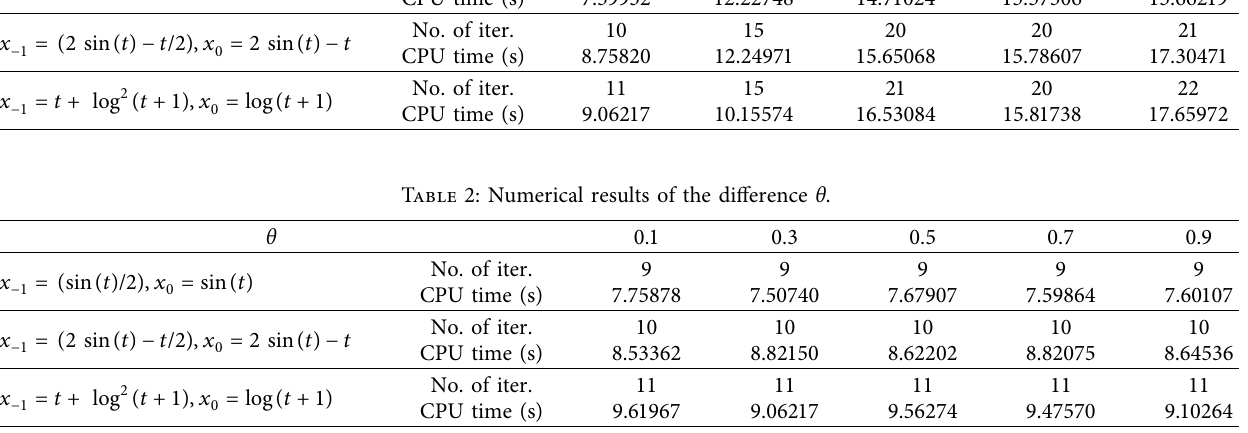
Table 3: Numerical results of the difference α